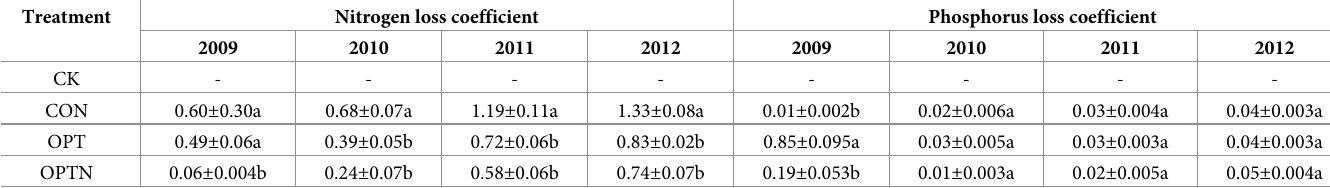
Table 2. Nitrogen and phosphorus loss coefficients, by treatments and growing season (%).